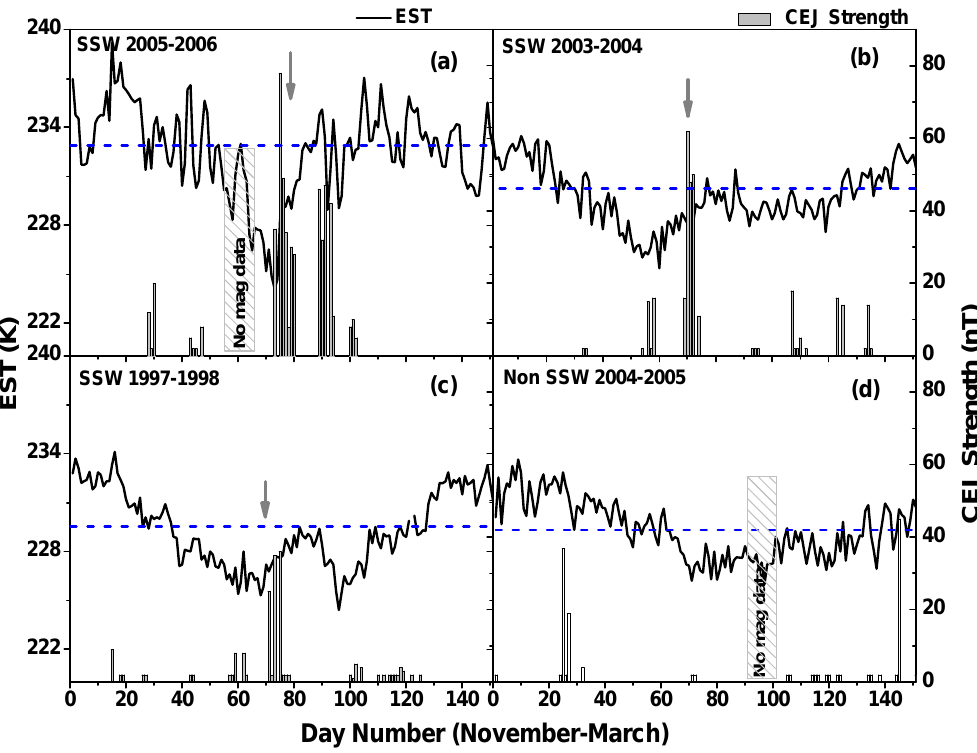
Fig. 3. Daily variation of stratospheric temperature (at 10hPa) over Trivandrum and the CEJ strength during the SSW years (a) (2005–2006), (b) (2003–2004), (c) (1997–1998) and a non-SSW year (d) (2004–2005). The central date of the major SSW is marked in each plot using vertical